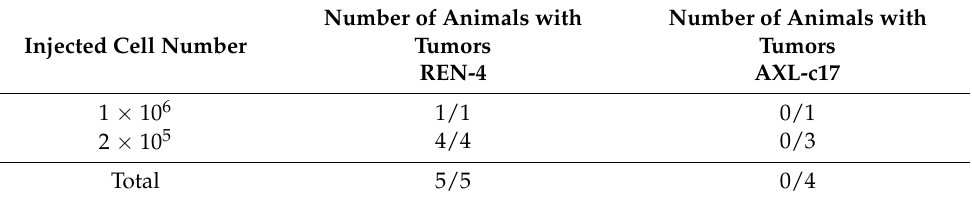
Figure 8. The scheme of animal experiments. Subcutaneous injection of control REN-4 cells induces tumor formation, whereas injection of AXL-c17 cells results in no tumor formation in all mice. Table 1. Results of Tumor Formation experiments. The number of animals and injected cell number in each group is listed.